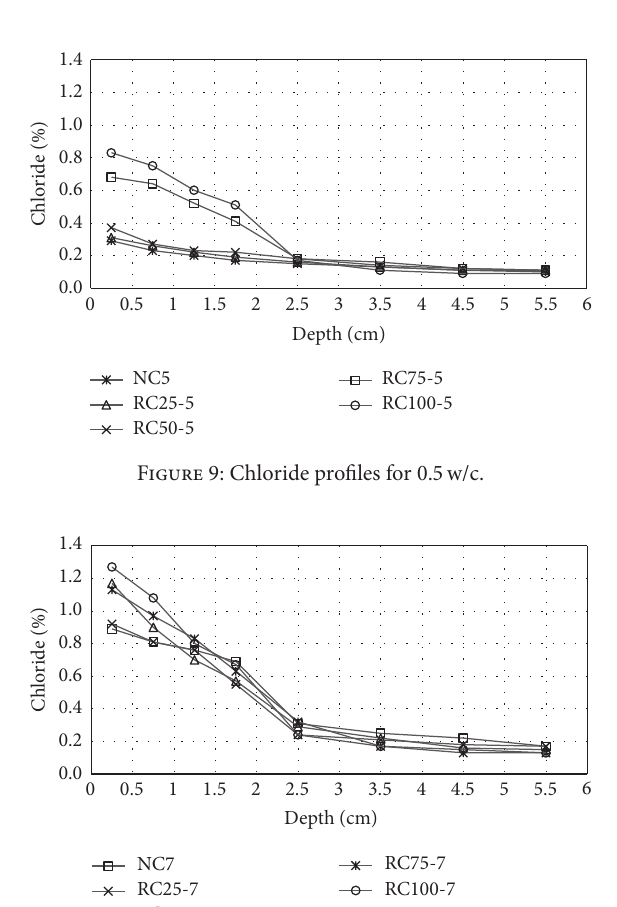
Figure 8: Carbonation versus air permeability.